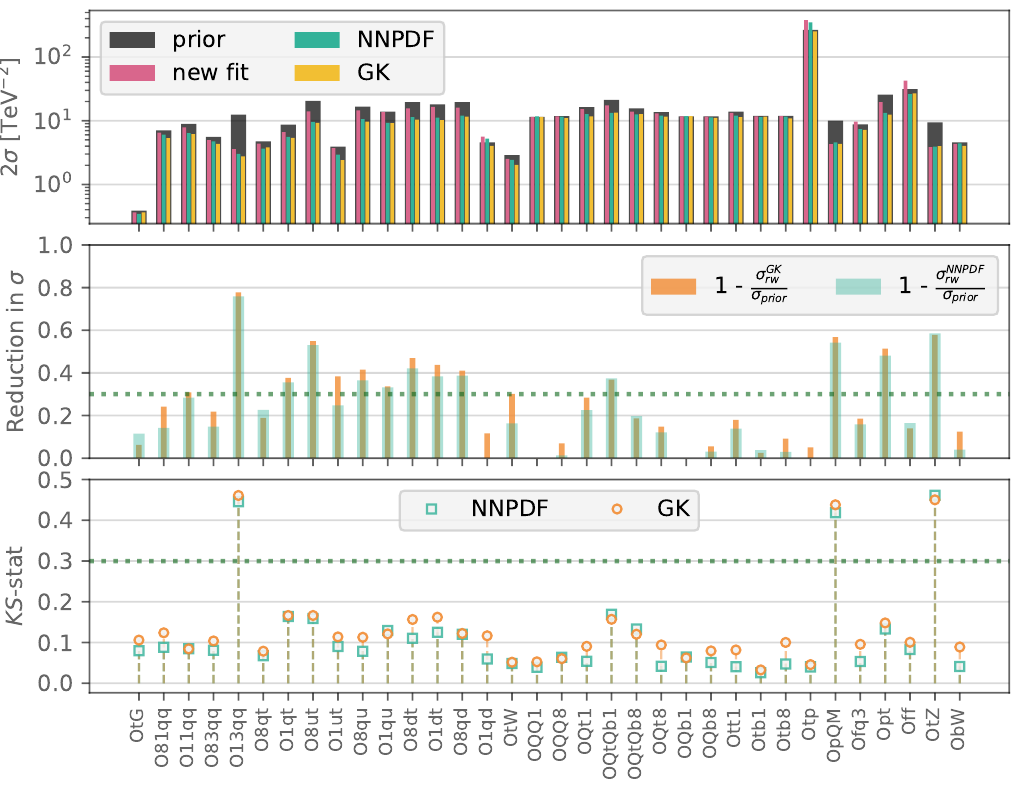
Figure 4.4: Same as Fig. 4.1 now with only one t -channel single-top dataset (the differential y t + ¯ t distributions from CMS at 8 TeV) added via reweighting